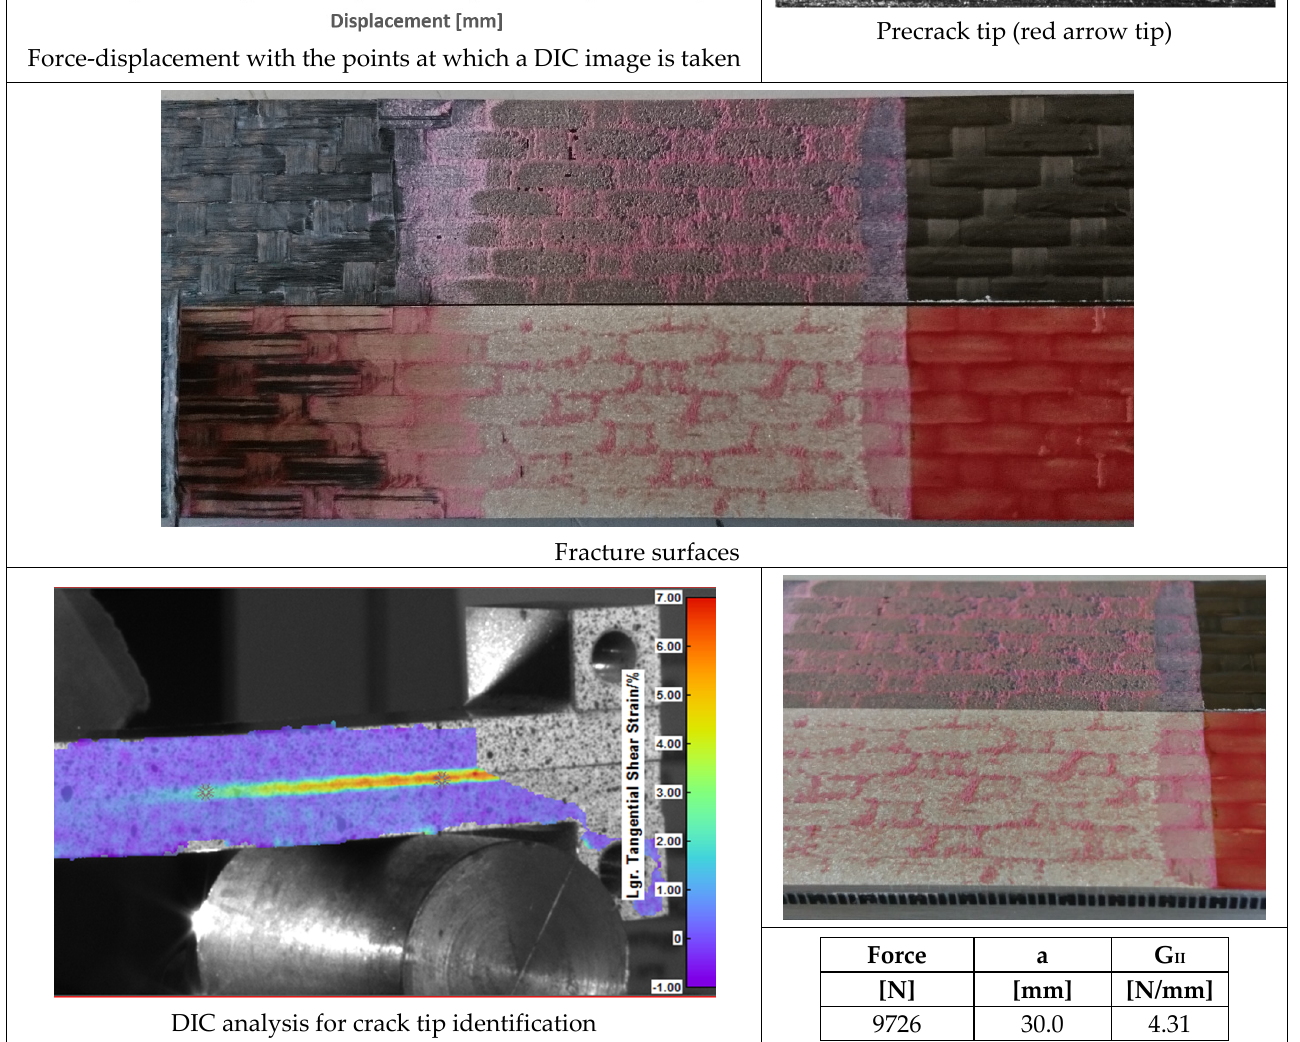
Figure 22. Results of the test on specimen ENF_AF163_03.